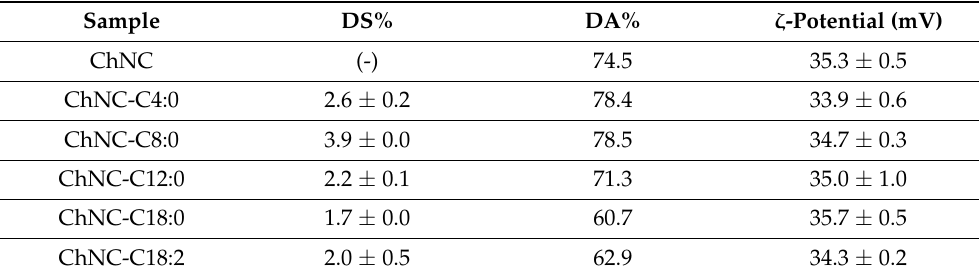
Figure 3. 13 C NMR spectra of ChNC (brown), ChNC-C4:0 (yellow), and ChNC-C12:0 (blue). The chemical structure of chitin and the fatty esters is provided, where n can be 2, 6, 10, or 16 depending on the fatty ester considered. Table 2. The degree of substitution (DS%), degree of acetylation (DA%), and ζ -potential at pH = 5.0 of (modified) chitin nanocrystals.